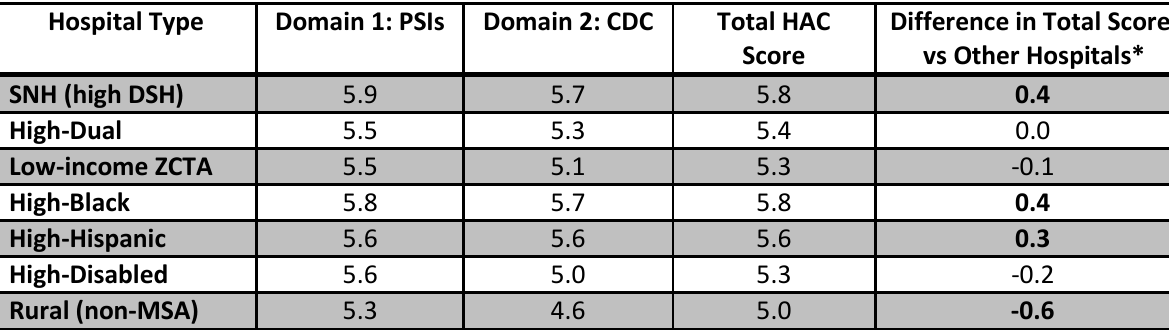
Table 6.9 compares each hospital type to all other hospitals – for example, safety-net hospitals as categorized by DSH Index versus non-safety-net hospitals. Overall, high-DSH hospitals were the worst performers on average, with an average Total HACRP Score of 5.8; this score was 0.4 points worse than non-high-DSH hospitals and was driven by poor performance in both Domain 1 and Domain 2. Rural hospitals were the best performers on average, with a Total HAC Score of 4.9. Table 6.9: Domain and Total HAC Scores by Hospital Type,